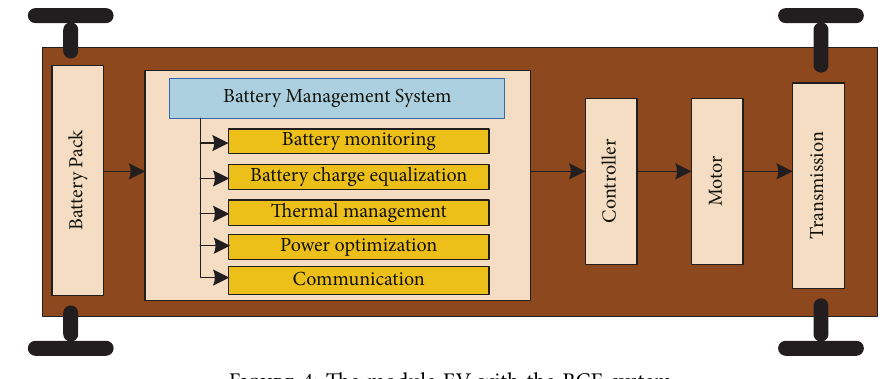
Figure 4: Te module EV with the BCE system.